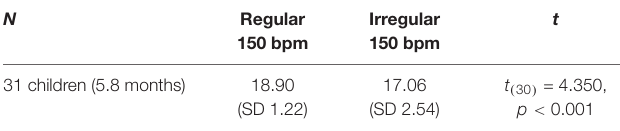
TABLE 2 | Mean scores and SD for the task presented at 150 bpm.